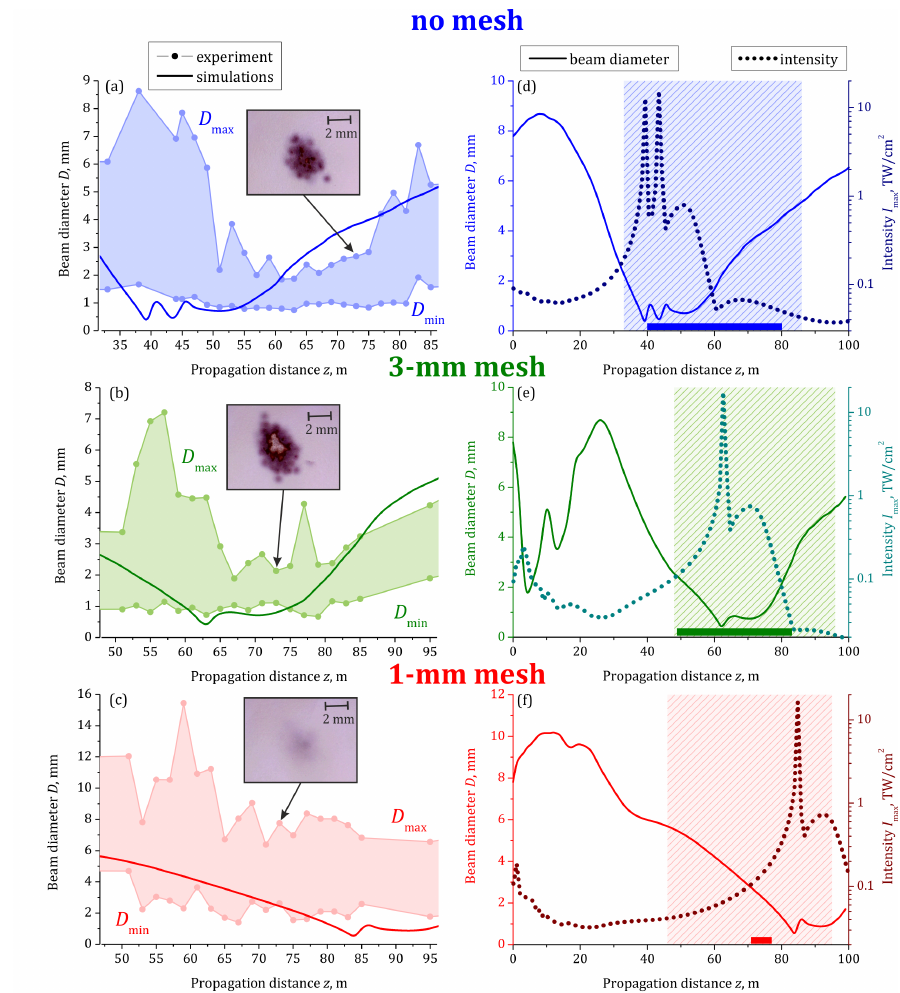
Figure 4. Dependencies of minimal D min and maximal D max measured out of 16 laser shots beam diameters (circles) on the propagation distance z in comparison with the beam diameter obtained from simulations (solid curves) for different modulation regimes: without modulation (( a ), blue), using 3 mm (( b ), green) and 1 mm (( c ), red) meshes. Sixteen measured at the certain propagation distance z diameters lie between D min and D max inside the filled area in ( a – c ). Insets in the left column show images of burns on the photographic paper at z ≈ 73 m. ( d – f ) Dependencies of beam diameter (solid curves) and maximal intensity (dotted curves) on propagation distance z obtained in simulations in the range of z from 0 to 100 m for all three cases. Colored rectangles highlight the regions shown in left column. Color bands in lower part of ( d – f ) demonstrate the range where the laser pulse triggered the electric